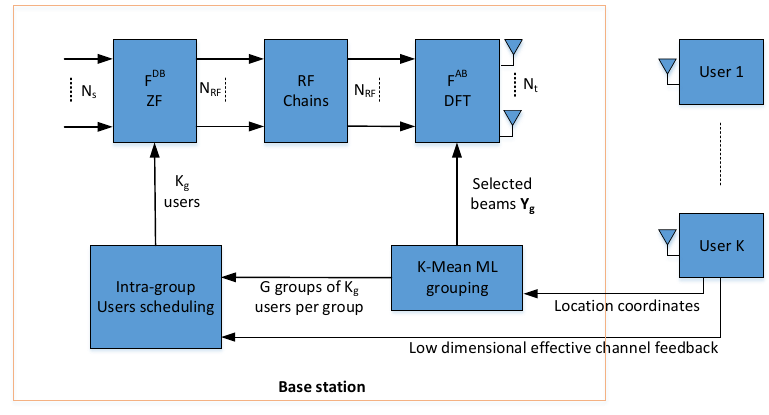
Figure 6. Joint users scheduling and hybrid beamforming architecture with ML-based users